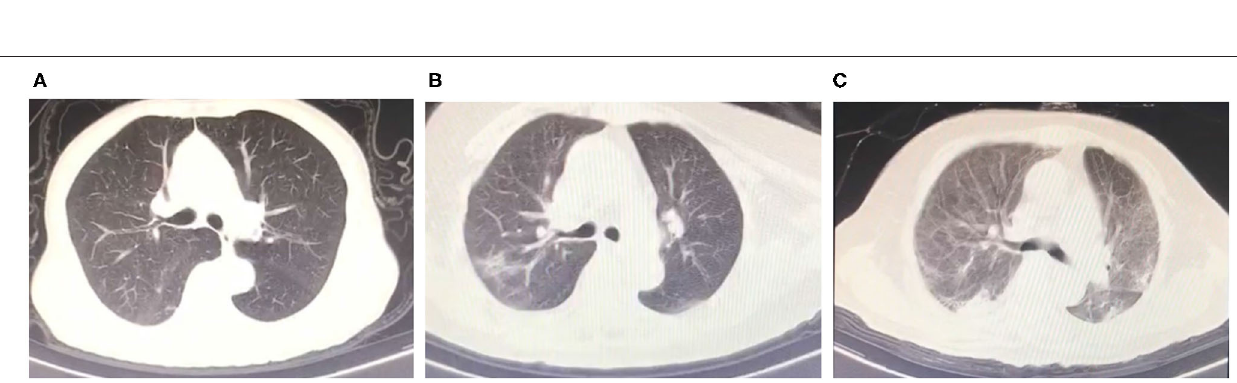
Frontiers in Medicine |